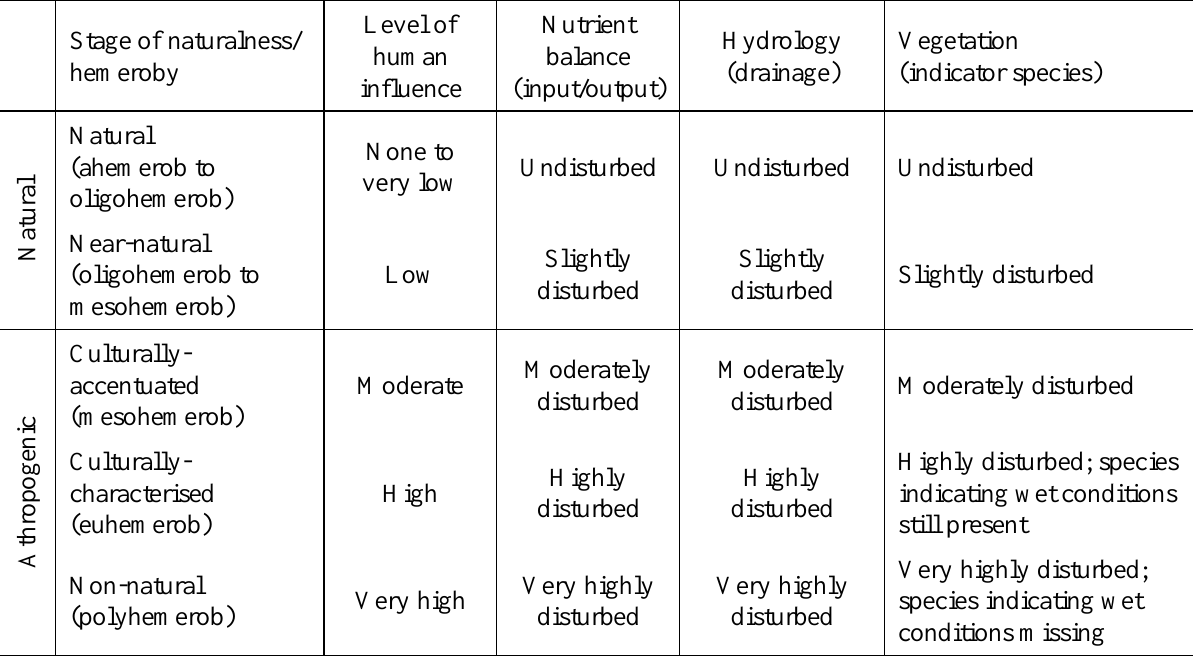
Table 1. Stages of naturalness and hemeroby (human modification) of peatlands (translated and slightly modified from Wagner & Wagner